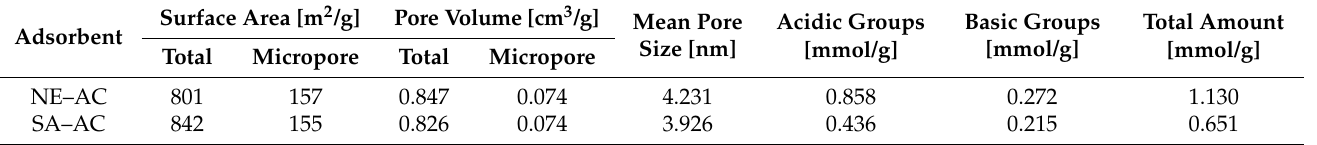
Table 1. Textural parameters and acidic/basic properties of the prepared activated